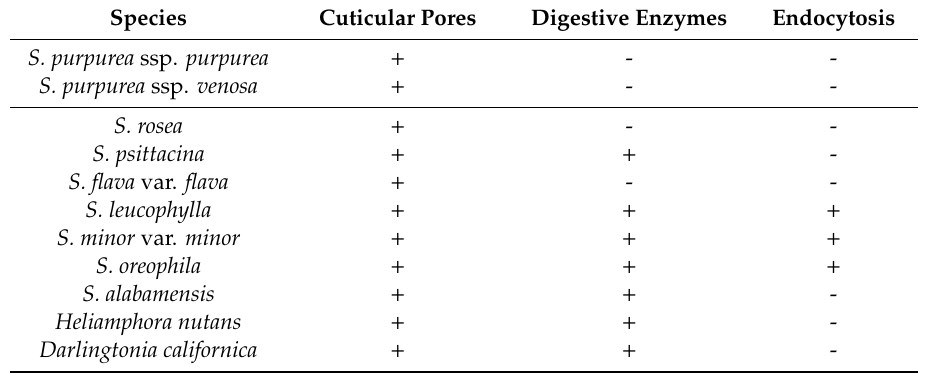
Figure 2. Methylene blue staining of cuticular pores in the absorptive zone ( a ) Sarracenia alabamensis ( b ) Sarracenia leucophylla ( c ) Sarracenia minor ( d ) Sarracenia oreophila ( e ) Darlingtonia californica ( f ) Sarracenia psittacina . Arrows indicate trichoblasts. Scale bar: 100 µm. Table 1. Results of the physiological analysis for enzyme formation, endocytosis, and methylene blue uptake.